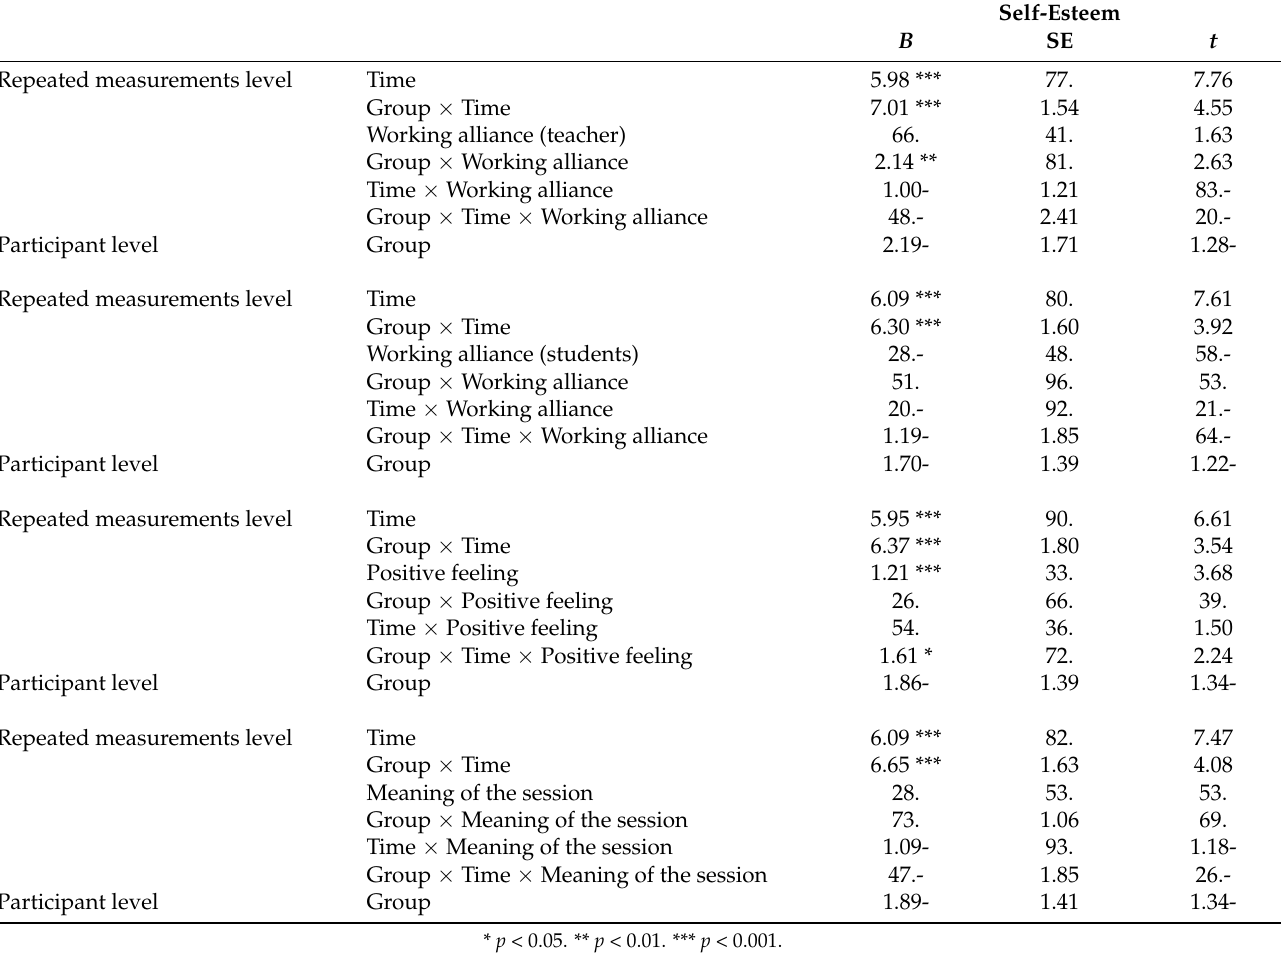
Table 4. HLM coefficients and their significance for assessing correlations between the working alliance, positive feelings, and meaning of the session indices, and the change in self-esteem as a function of group.